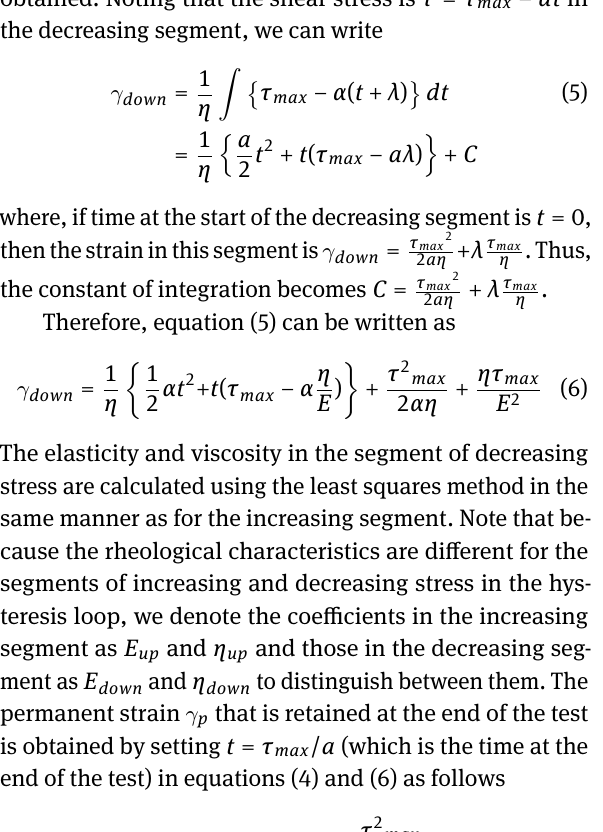
Figure2depictsanexampleofthestrainresponsetothehys- teresis loop test according to the single relaxation